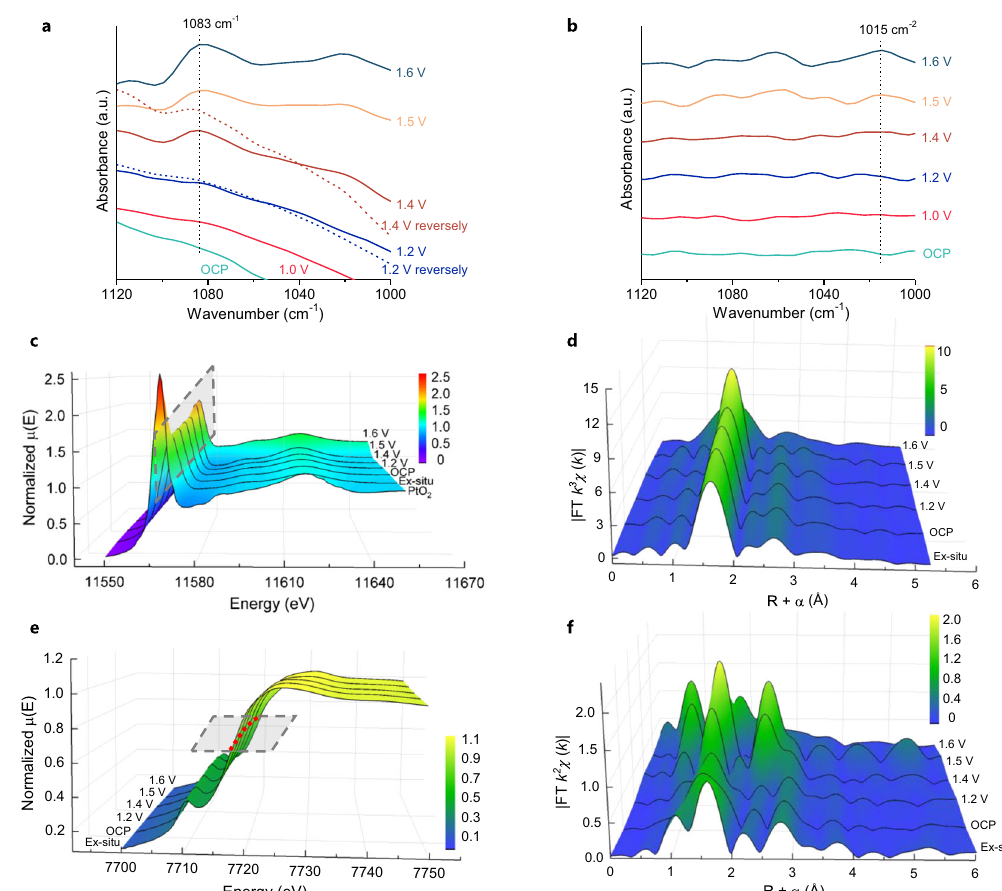
Fig. 3 Operando ATR-FTIR and XAFS spectra of catalysts under different applied potentials. a , b Operando potential-dependent ATR-FTIR spectra for Pt 1 /CoHPO ( a ) and CoHPO ( b ). c – f , Operando potential-dependent XAFS spectra of the XANES ( c , e ) and FT-EXAFS ( d , f ) at the Pt L 3 -edge ( c , d ) and Co K-edge ( e , f ) of Pt 1